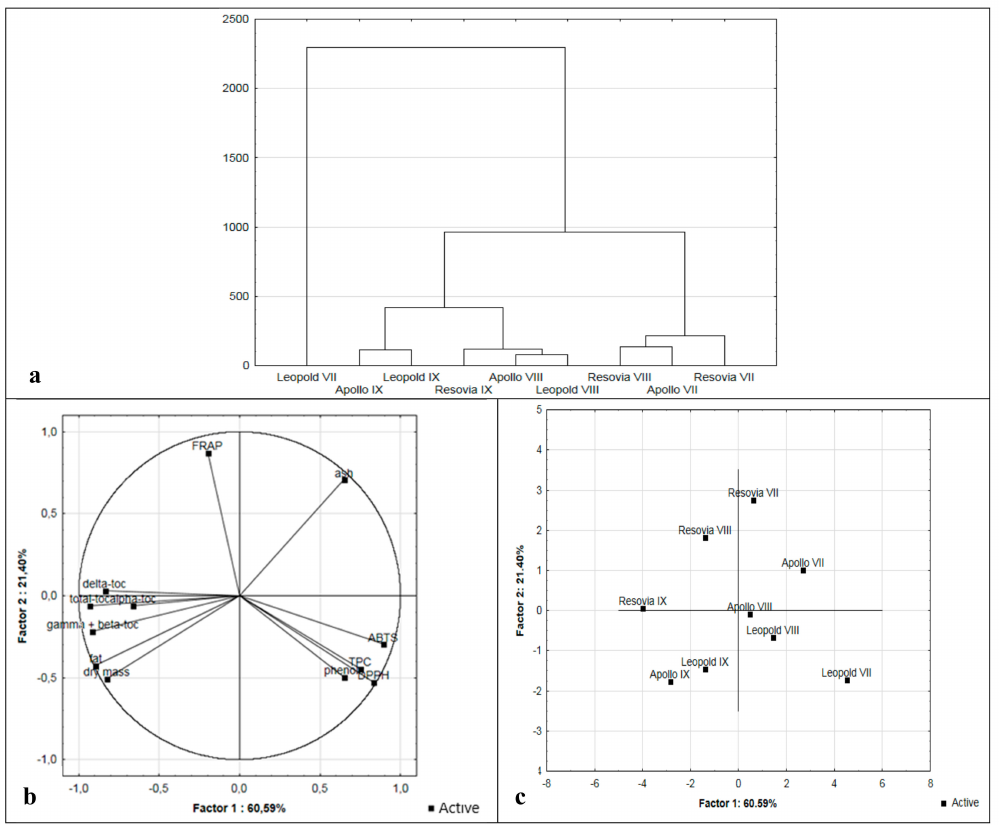
Figure 1. Analysis of main components: ( a ) Dendrogram; ( b ) distribution of the analyzed parameters; ( c ) distribution of walnut